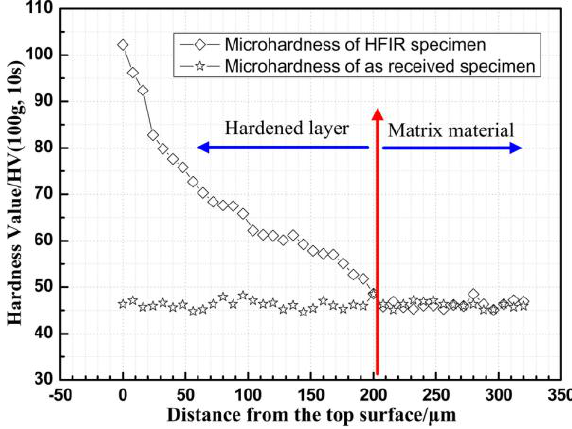
Figure 4. The cross-sectional microhardness of as-received and HFIR specimen.